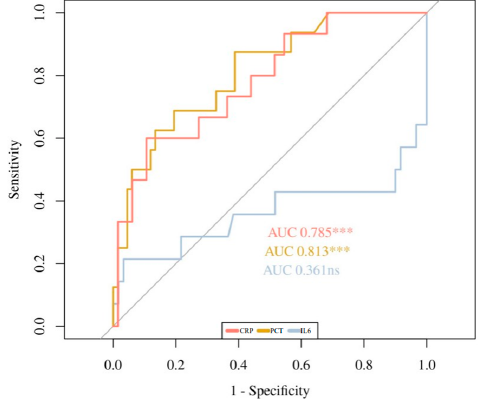
Figure 3. ROC Curves of CRP-2vs1, PCT-2vs1, and IL6-2vs1. ns: non significance. *** p < 0.001.